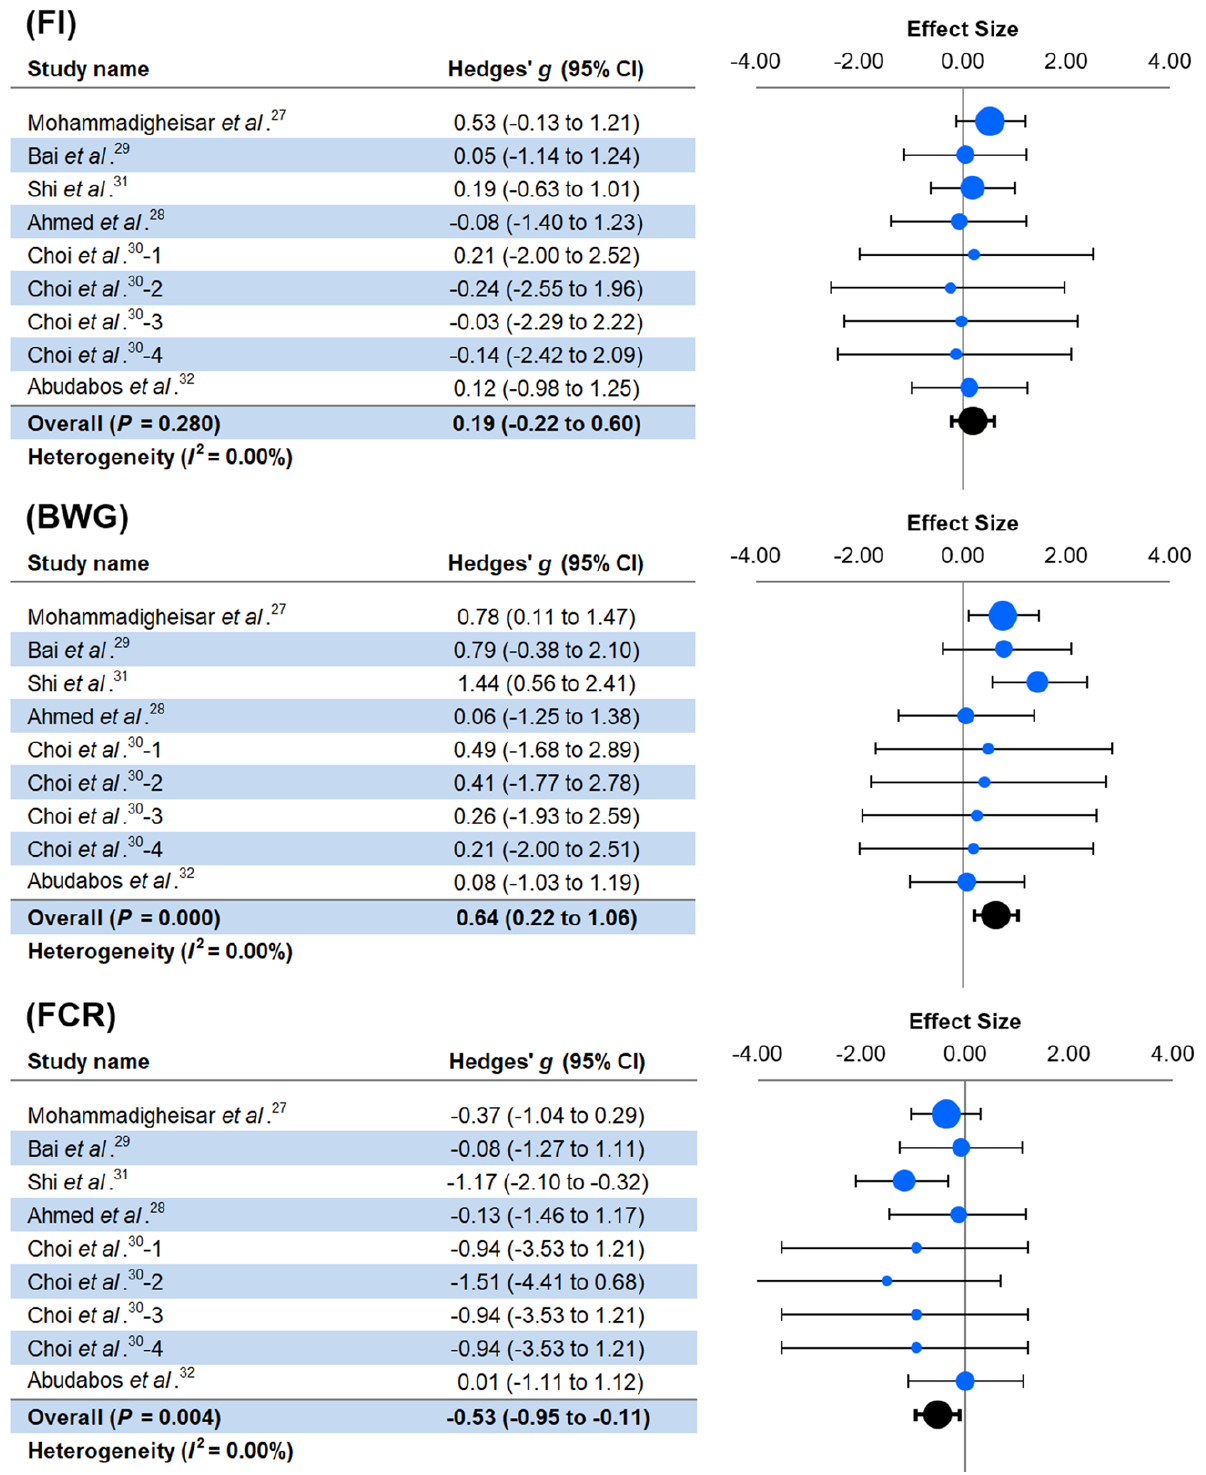
Figure 2. Forest plot showing the effect of dietary seaweed inclusion on growth performance of broiler chicken. FI: feed intake, BWG: body weight gain, FCR: feed conversion ratio, CI: confidence interval.